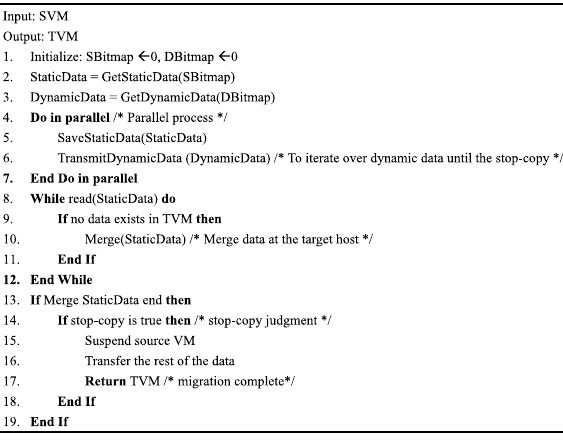
Adaptive hybrid migration